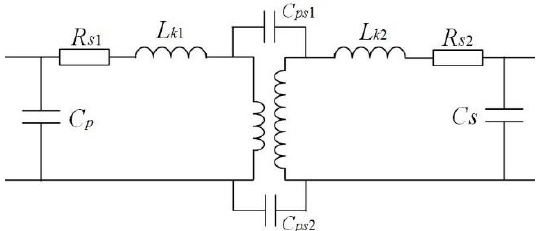
Figure 16. High-frequency equivalent circuit of transformer. R s1 : Winding resistance of the primary side; R s2 : winding resistance of the secondary side; L k1 : leakage inductance of the primary side; L k2 : leakage inductance of the secondary side; C p : winding capacitance of the primary side; C s : winding capacitance of the secondary side; and C ps1 , C ps2 : winding stray capacitance between the primary side and the secondary side.